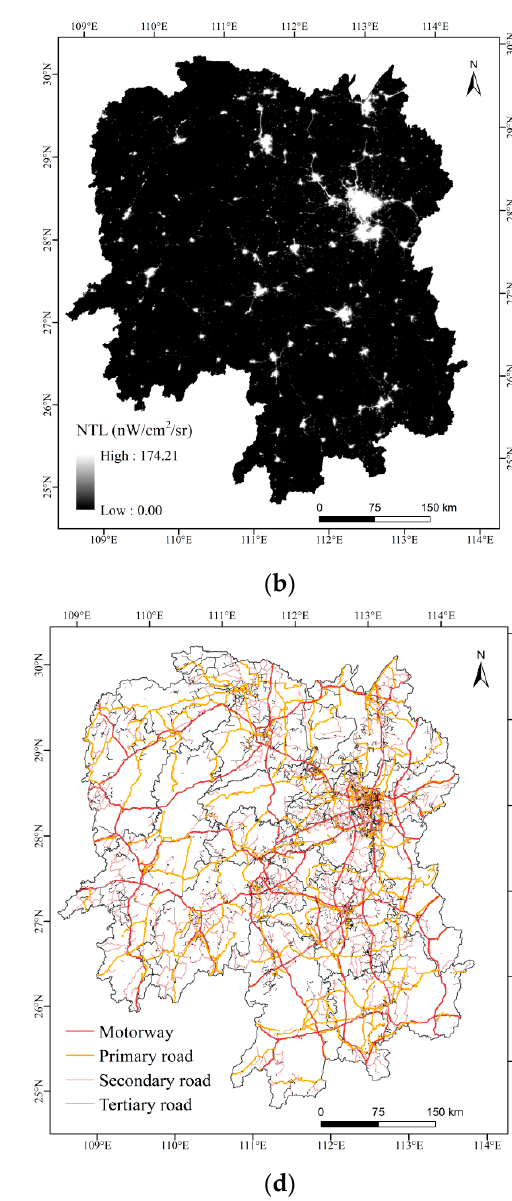
Figure 1. Datasets used in this study. ( a ) SRTM DEM data, ( b ) NPP-VIIRS nighttime light images, ( c ) land use data, and ( d ) OSM road data.